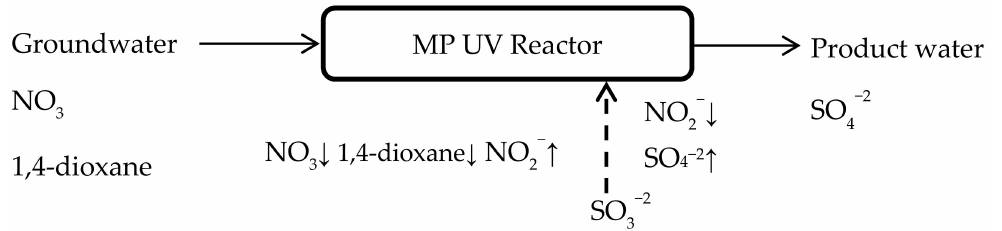
Figure 9. The schematic representation of the UV/NO 3 + SO 32 −